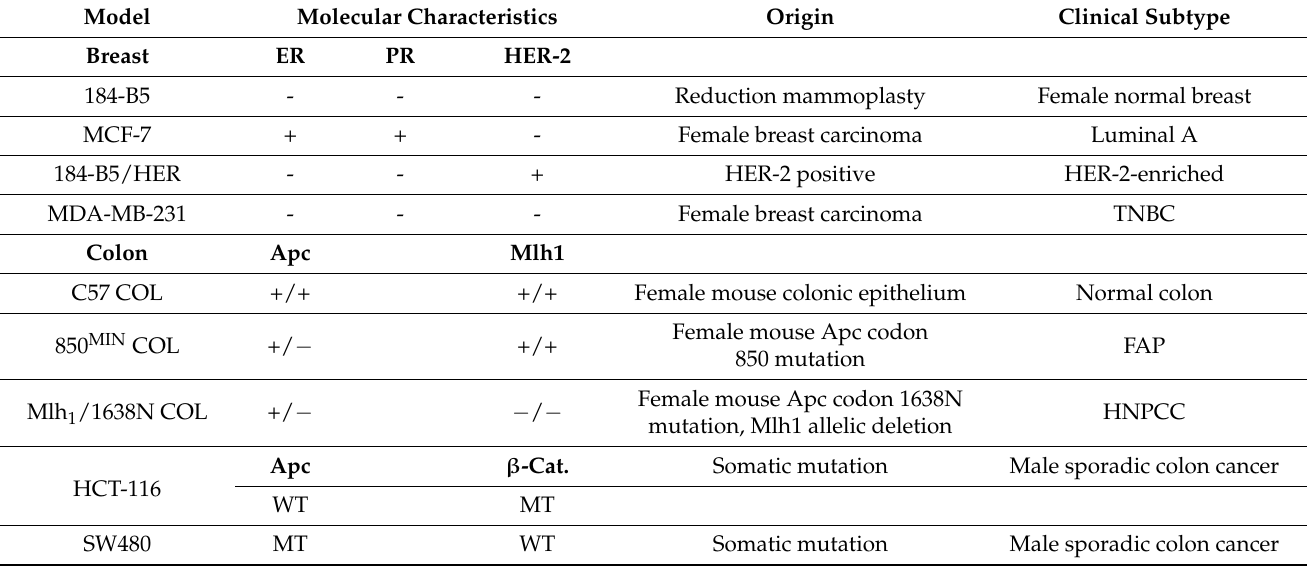
Table 1. Cellular models for breast and colon cancer.